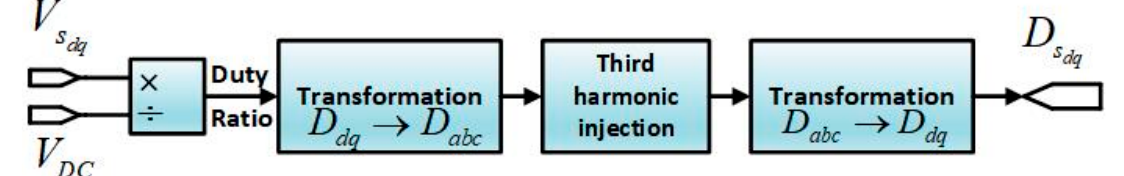
Figure 4. Modulation of generator-side converter in proposed model.